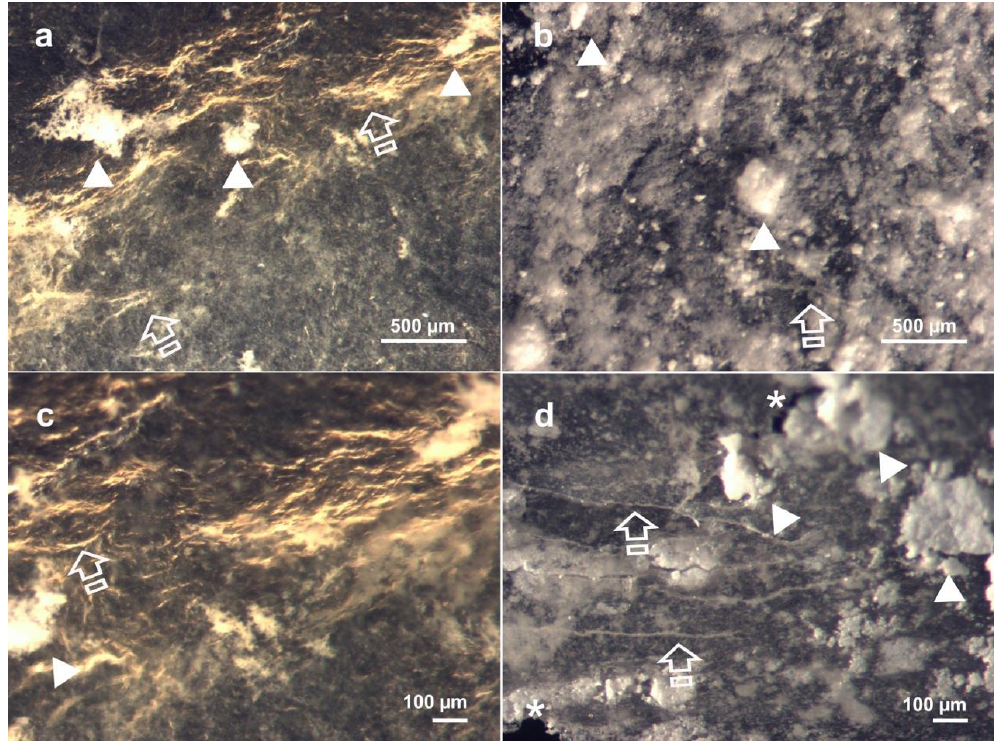
Figure 4. Light micrographs taken from matrices after PBS degradation assay after 7 days of storage. ( a ) Fibro-Gide surface at 60× magnification. ( b ) Mucograft surface at 60× magnification. ( c ) Fibro-Gide at 120× magnification. ( d ) Mucograft at 120× magnification. Scale bar is 500 µm in ( a , c ); and 100 µm in ( b , d ). Different layers of collagen fibers (arrows) caused by degradation with some mineral deposits (arrow heads) on its surface. The lack of integrity of the matrices corresponds with structural defects (asterisks).